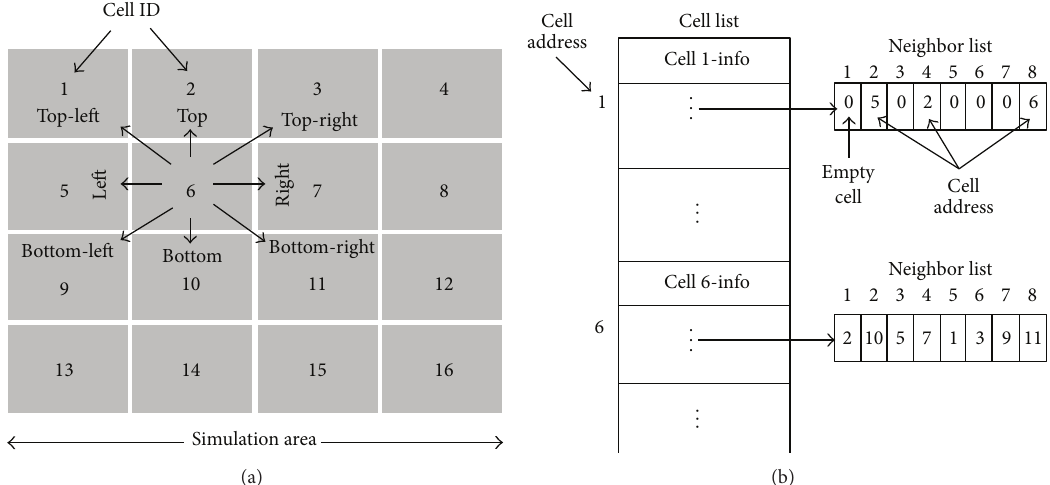
Figure 3: (a) Illustration of the cell formation. (b) Illustration of the storage system of cell and address of nearest neighbors of each cell in cell list.